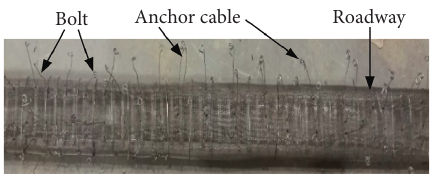
Figure 2: Roadway model